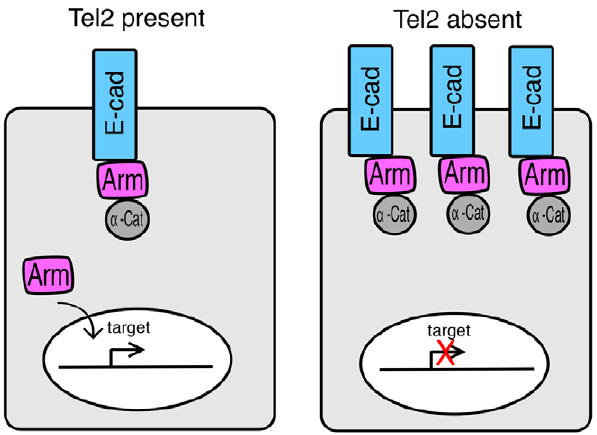
Figure 9. The effect of Tel2 on Wingless signaling. A model for how Wingless signaling is compromised in the absence of Tel2 is illustrated. We speculate that in the absence of Tel2, increased E- cadherin at the plasma membrane sequesters Armadillo (Arm) so that little remains free in the cytoplasm to enter the nucleus in response to Wingless